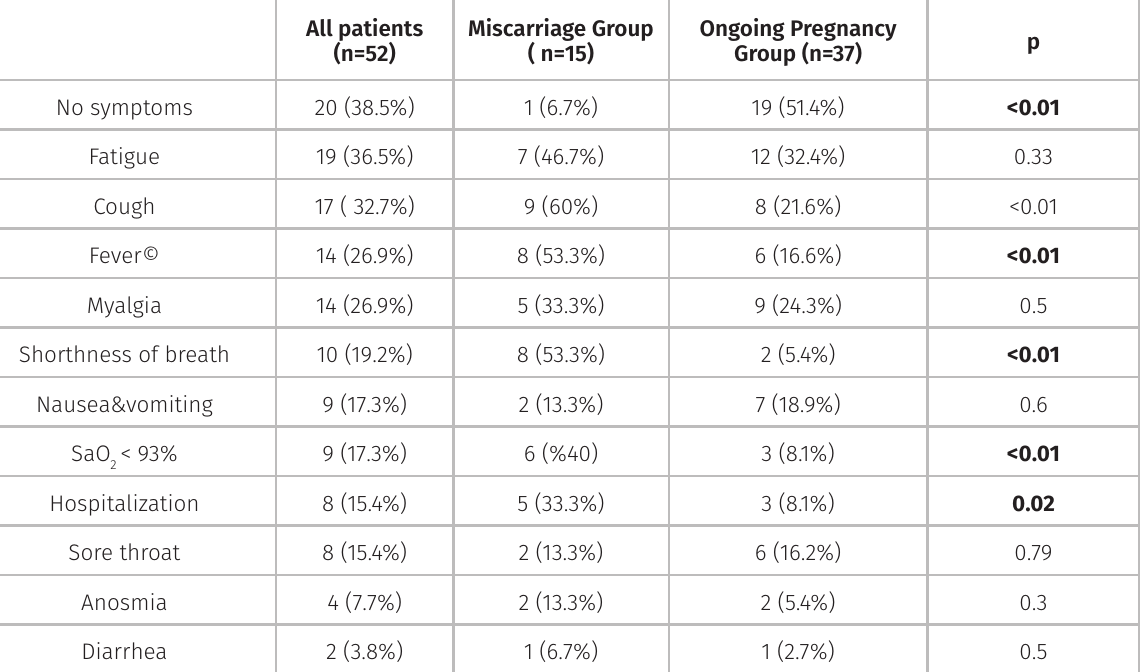
Table II. Symptoms and signs.